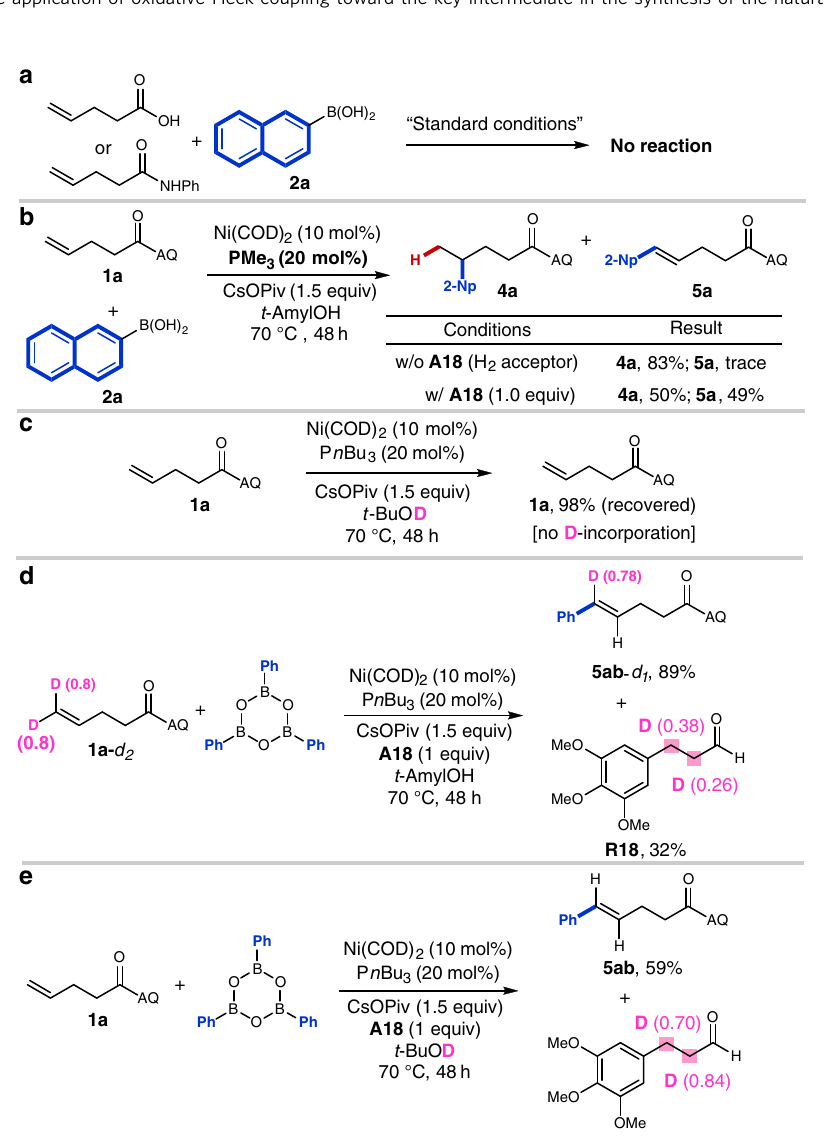
Fig. 3 Experiments to elucidate Heck coupling mechanism. a Control experiments establishing the need for the AQ-directing group in both hydroarylation and Heck coupling. b The role of the compound A18 . c The importance of aryl boronic acid in alkene insertion. d The reaction with δ , δ -di-deuterated alkene 1a - d 2 . e Deuteration experiments in t -BuOD